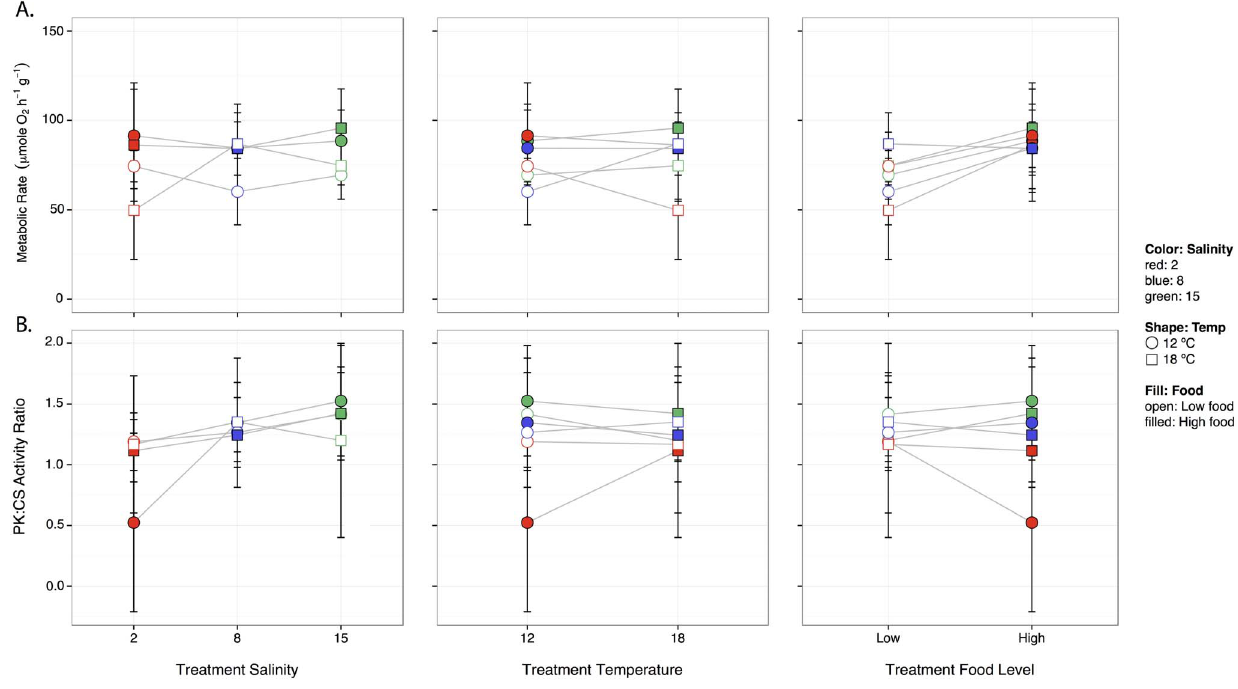
Figure 3. Laboratory measurements of clam metabolism under each treatment condition. Metabolic rate A and PK:CS ratio B as a function of treatment temperature (panel 1), treatment salinity (panel 2), and treatment food level panel 3, in the laboratory. Values represent means + / 2 95% confidence intervals, n=10 in A and n=6 in B.